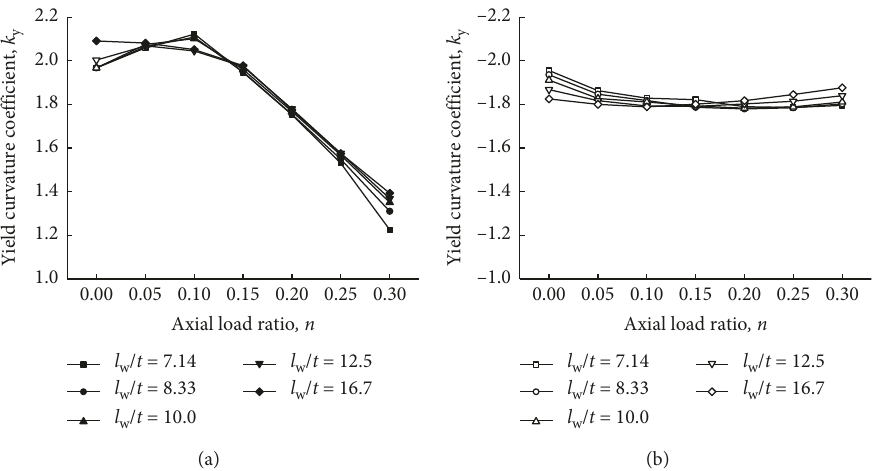
Figure 11: Variations in the yield curvature coefficient with the axial load ratio at different web height to thickness ratios. (a) Flange in tension. (b) Flange in